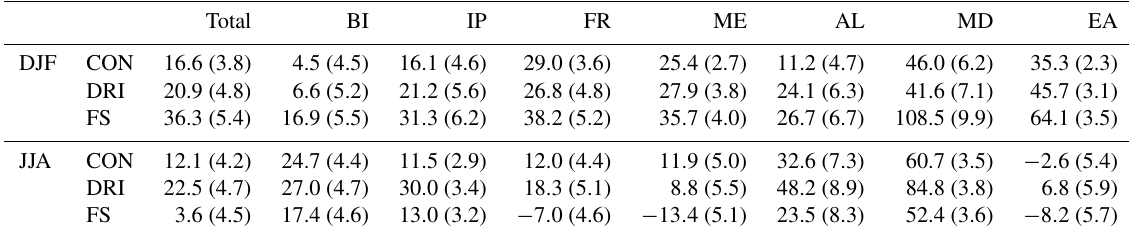
Table 3. The daily accumulated precipitation bias (%) and root mean square error (RMSE) (in brackets) between the downscaled simulations and E-OBS for the total domain and the subdomains (BI, IP, FR, ME, AL, MD, EA) during DJF and JJA for the 10-year period from 1991 to 2000. Total BI